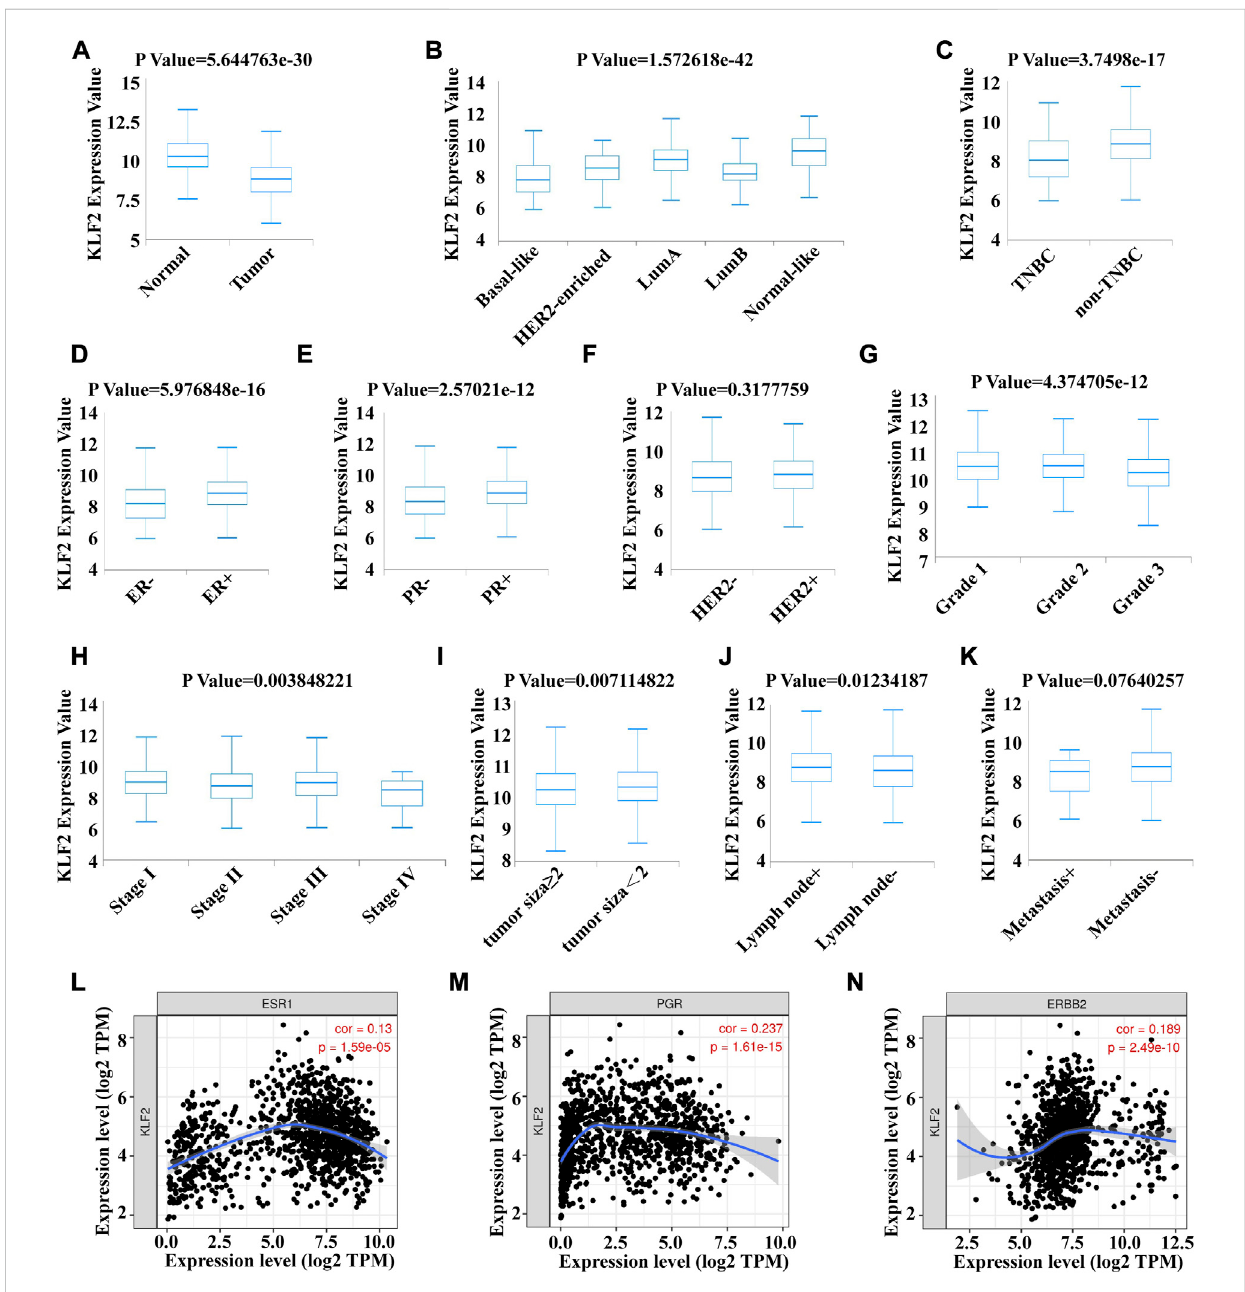
FIGURE 2 Correlation between KLF2 mRNA expression and various clinicopathological parameters in patients with breast cancer. The KLF2 mRNA expression level were determined using BCIP in (A) normal and tumor tissue, (B) subtypes, (C) TNBC and non-TNBC, (D) ER status, (E) PR status, (F) HER2 status, (G) pathologic grade, (H) pathologic stage, (I) tumor size, (J) lymph node metastases and (K) distant metastasis. Association between the expression level of KLf2 and ER (L) , PR (M) and HER2 (N) . *, p < 0.05; **, p < 0.01; ***, p < 0.001; ns, no signi fi